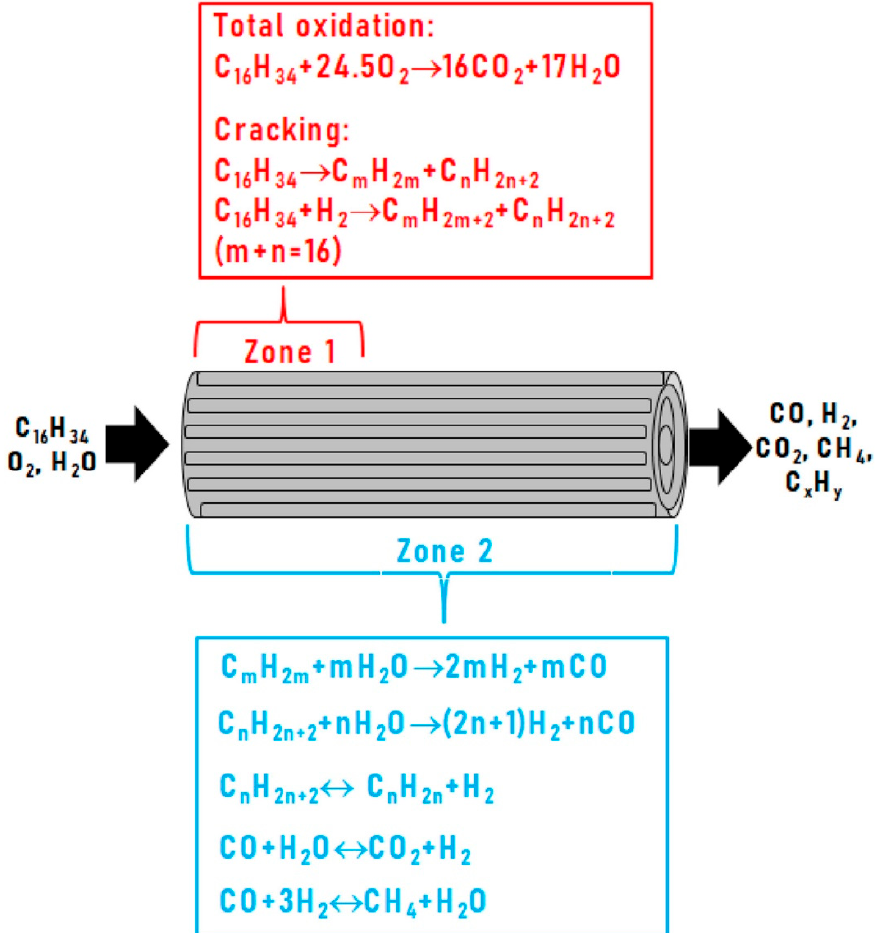
Figure 10. Scheme of autothermal reforming of hexadecane [96].